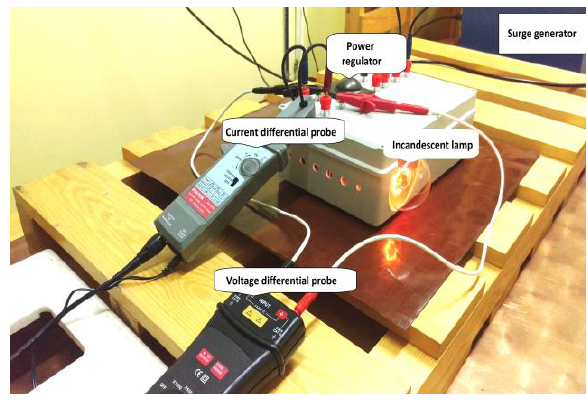
Fig. 4. Tested system.